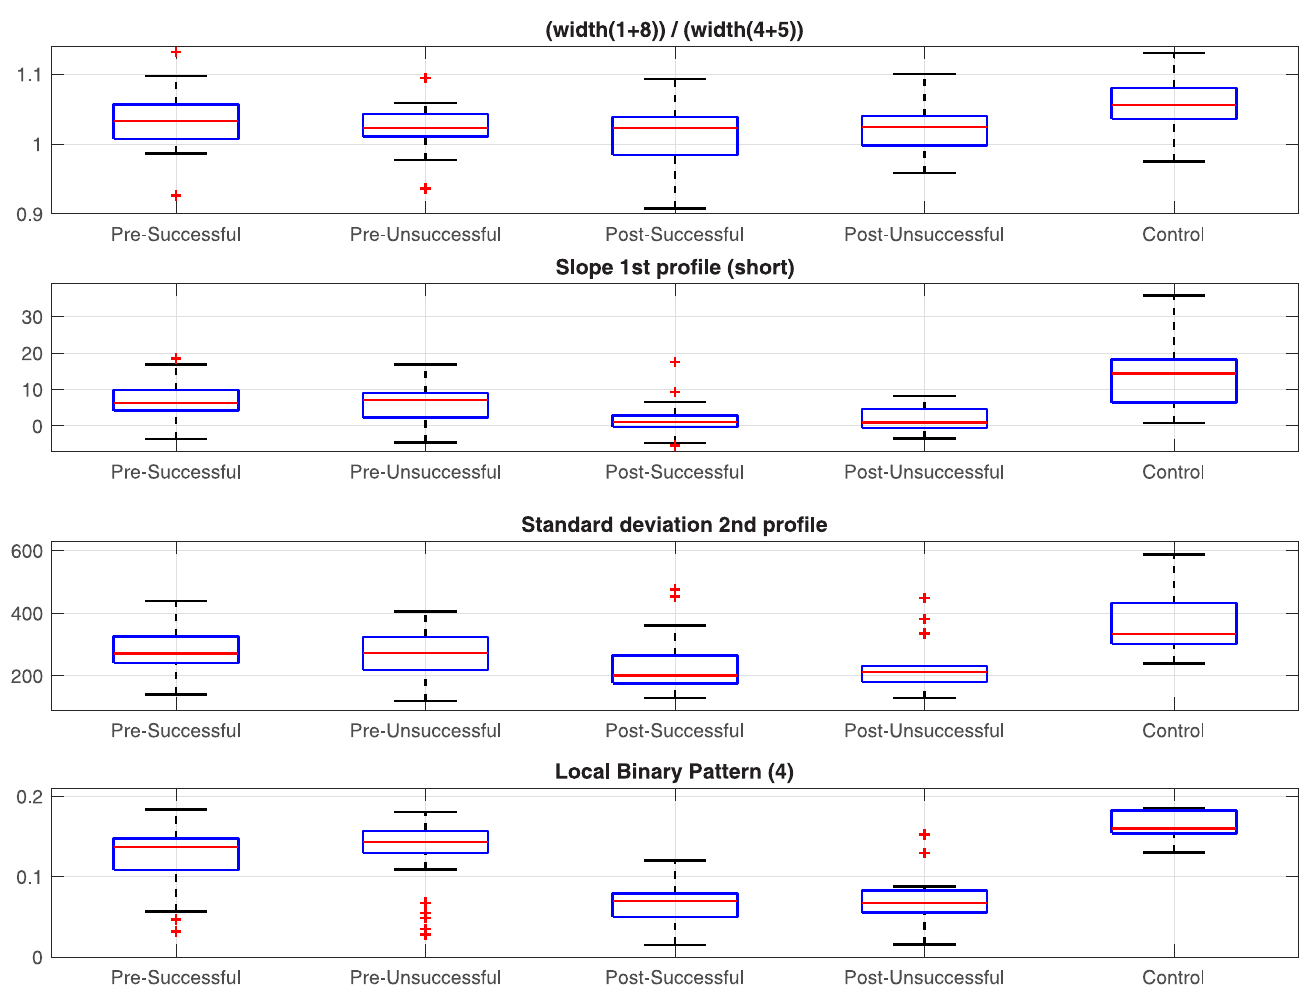
Fig 10. Boxplots corresponding to distributions of four representative measurements. The differences between control and patients and the pre- and post- intervention cases are noticeable but within the pre-intervention and post-intervention groups are very close to each other.